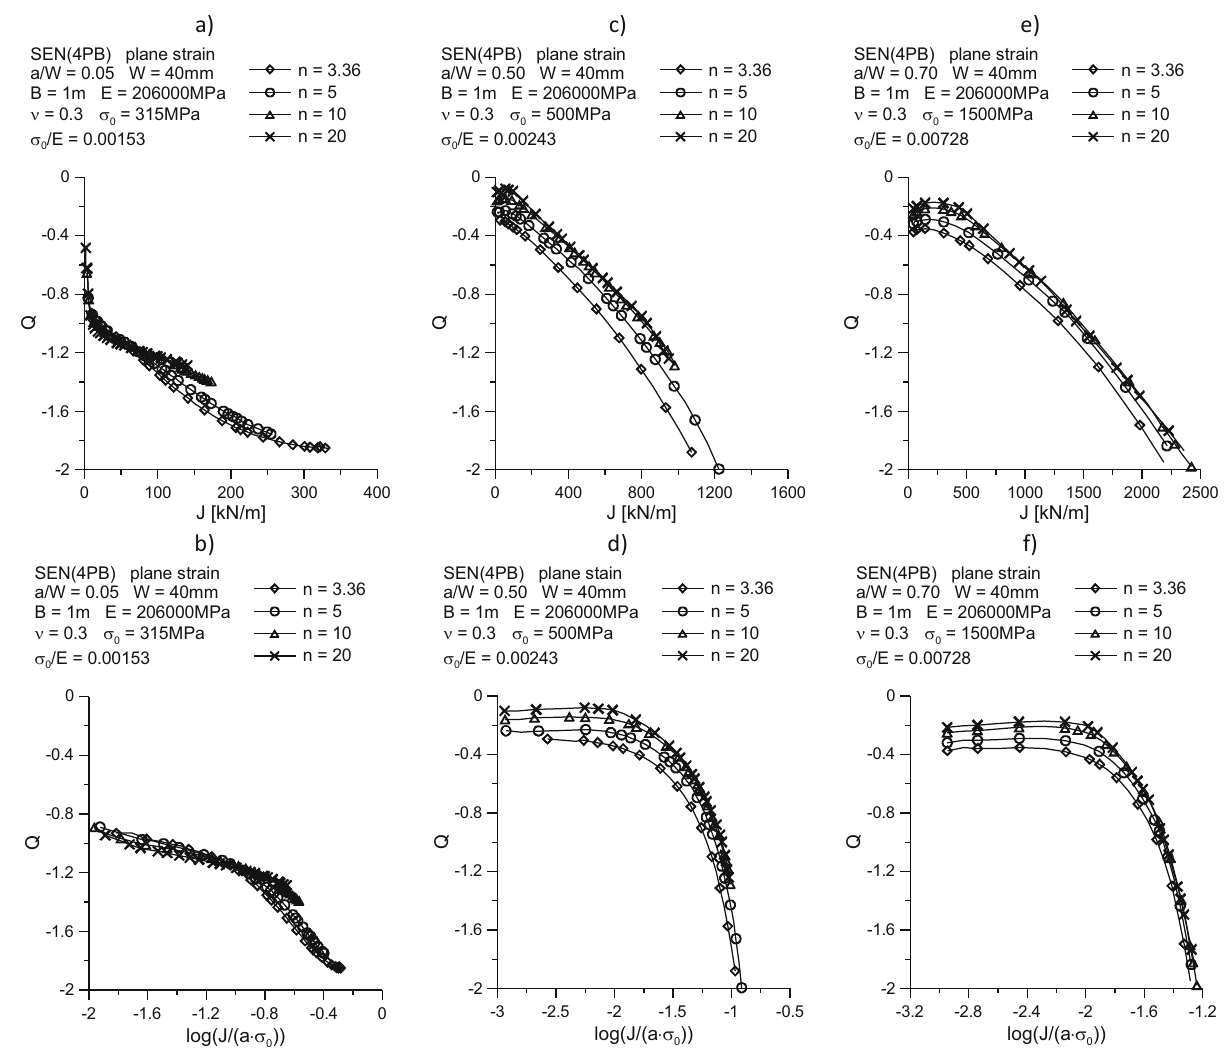
Figure 25: In fl uence of the strain hardening exponent n on the distribution of the Q = f ( J ) and Q = f ( log ( J / ( a · σ 0 ))) curves for SEN ( 4PB ) specimens dominated by the plane strain state: ( a and b ) σ 0 = 315 MPa, a / W = 0.05; ( c and d ) σ 0 = 500 MPa, a/W = 0.50; ( e and f ) σ = 1,500 MPa, a / W = 0